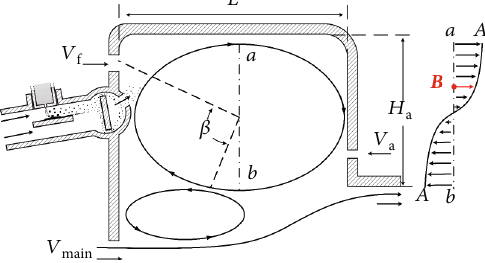
Figure 7: Schematic of fl ame stability in a trapped